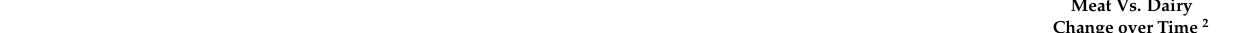
Meat Vs. Dairy Change over Time